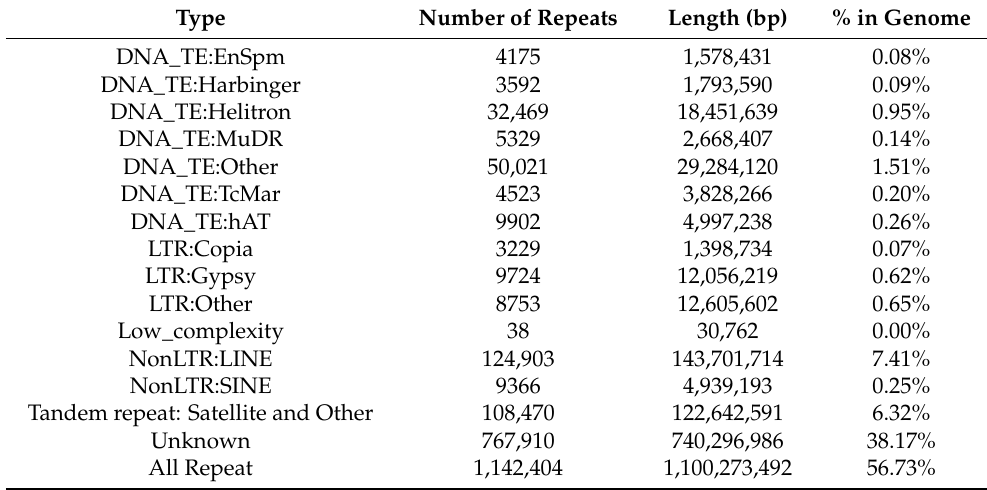
Table 4. Statistics of the classification results of repeat sequences from the M. chilensis genome.